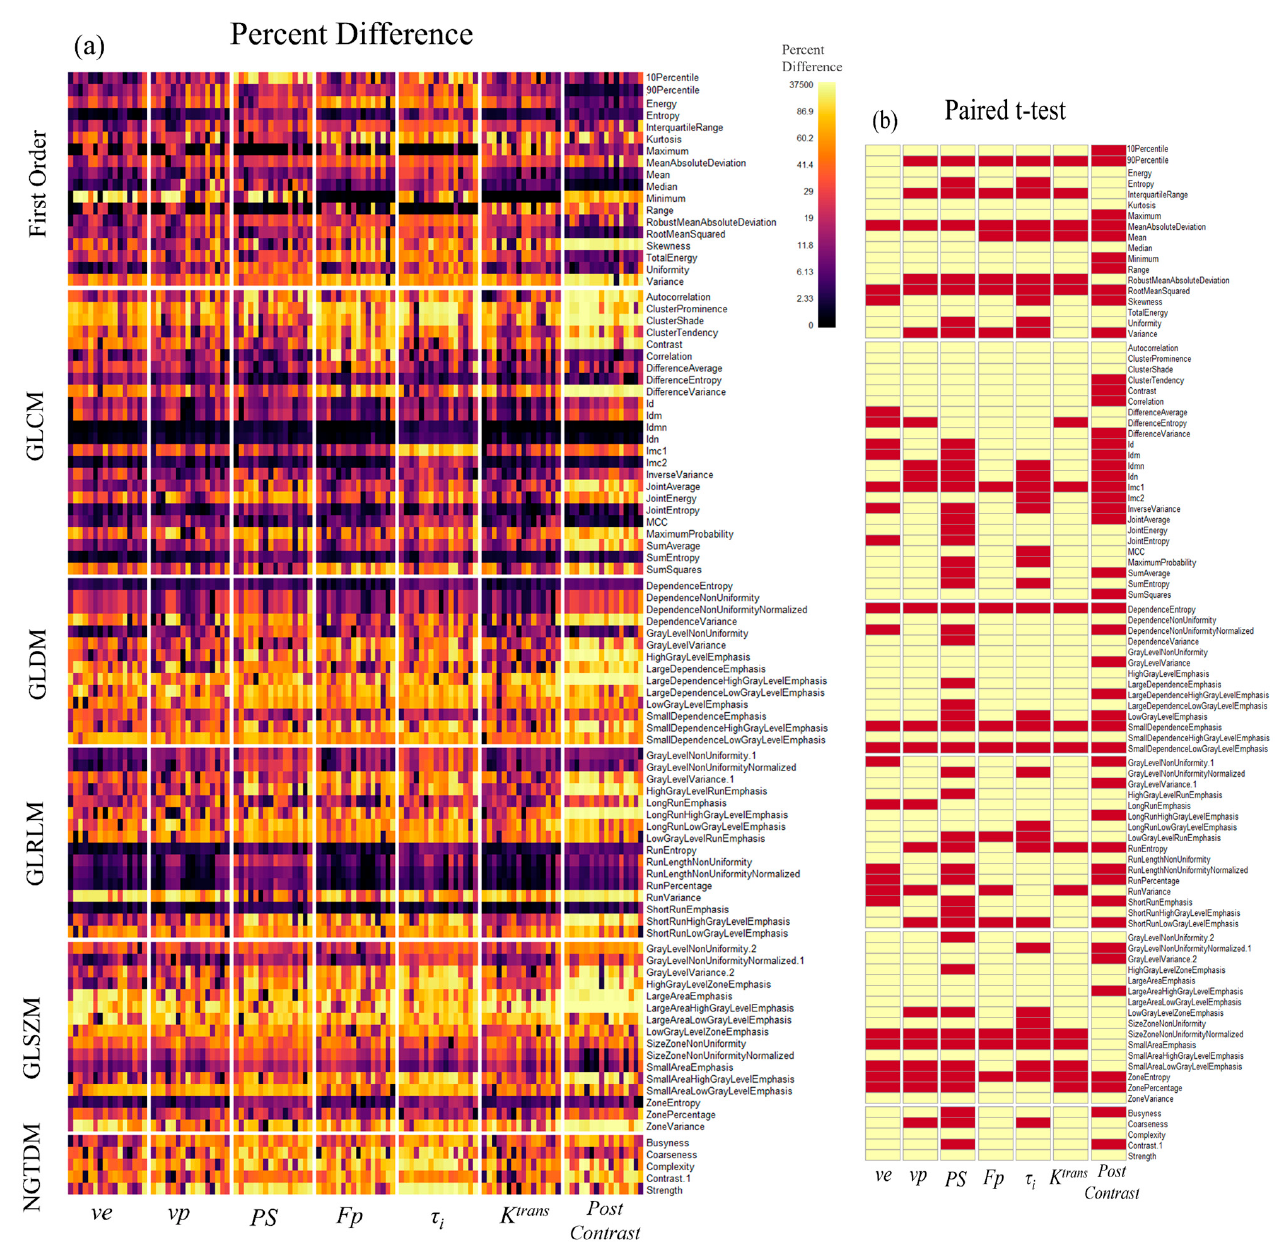
Figure 5. Percent difference and significance between features from isotropic and anisotropic (slice thickness of 1.014 mm) images. ( a ) A heatmap depicting the percent difference in histogram and texture features between isotropic parameter maps and up-sampled anisotropic maps (slice thickness of 1.014 mm in axial direction). ( b ) A heatmap showing the features that have a significant difference in radiomic features ( p < 0.00054, depicted in red) between isotropic and anisotropic image resolution, which are over 32% of all features.